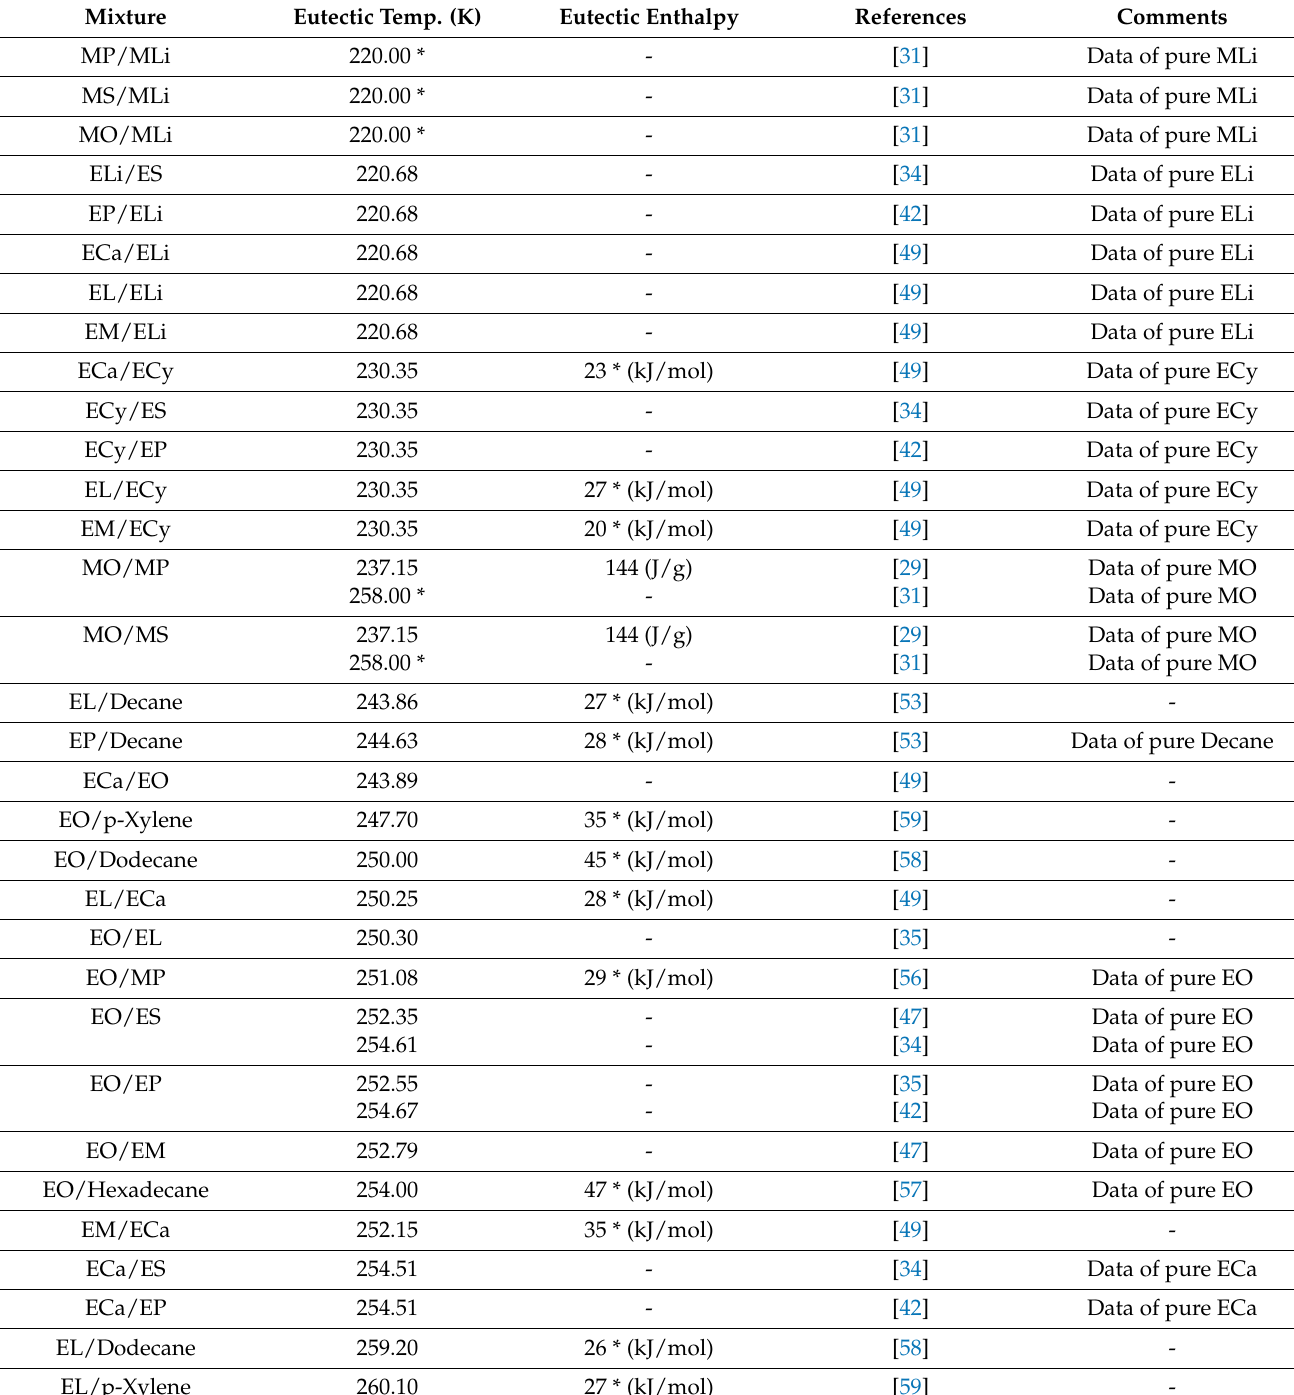
Table 3. References reported in this paper, ordered ascendingly according to the eutectic temperature. Numbers marked with an asterisk (*) have been approximately estimated from a graph in the original